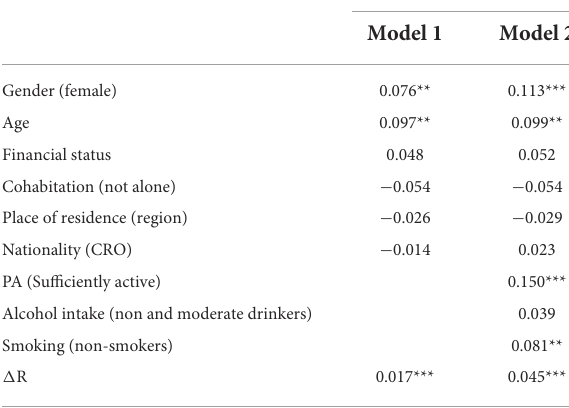
TABLE 3 Prediction of Mediterranean diet from sociodemographic, health behavior variables in Lithuanian and Croatian university